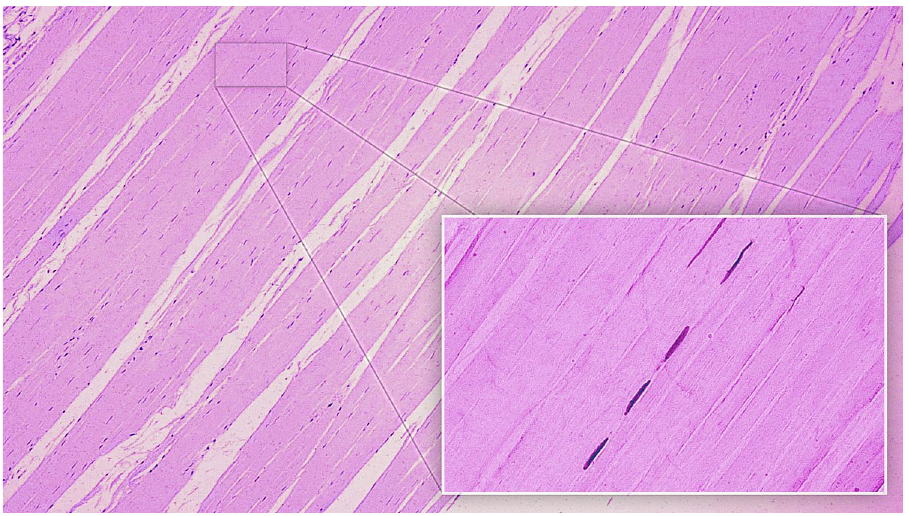
Figure 5. Histological examination of the accessory band of the plantaris